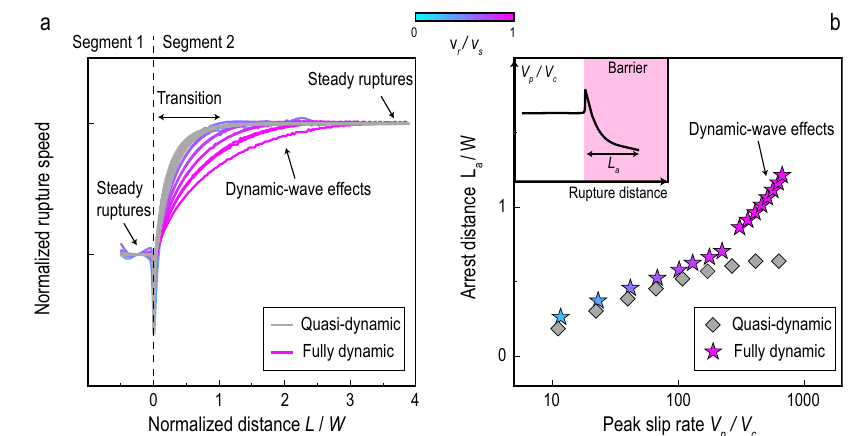
Fig. 3 | Non-steady rupturesdue to along-strike heterogeneities. a Curves show the transition of rupture speeds from one steady state in segment 1 to another steady state in segment 2 in fully dynamic (coloured curves) and quasi-dynamic (grey curves) simulations. Colour indicates the steady rupturespeed in segment 2. b Rupturearrestdistancesinsideabarrierversusthepeakslipratebeforereaching